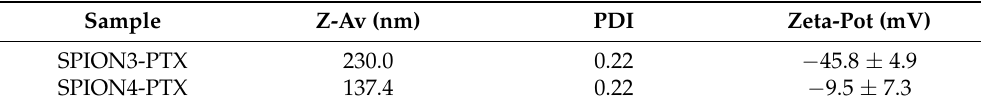
Table 3. Z-Av and Z-Pot measurements of SPION